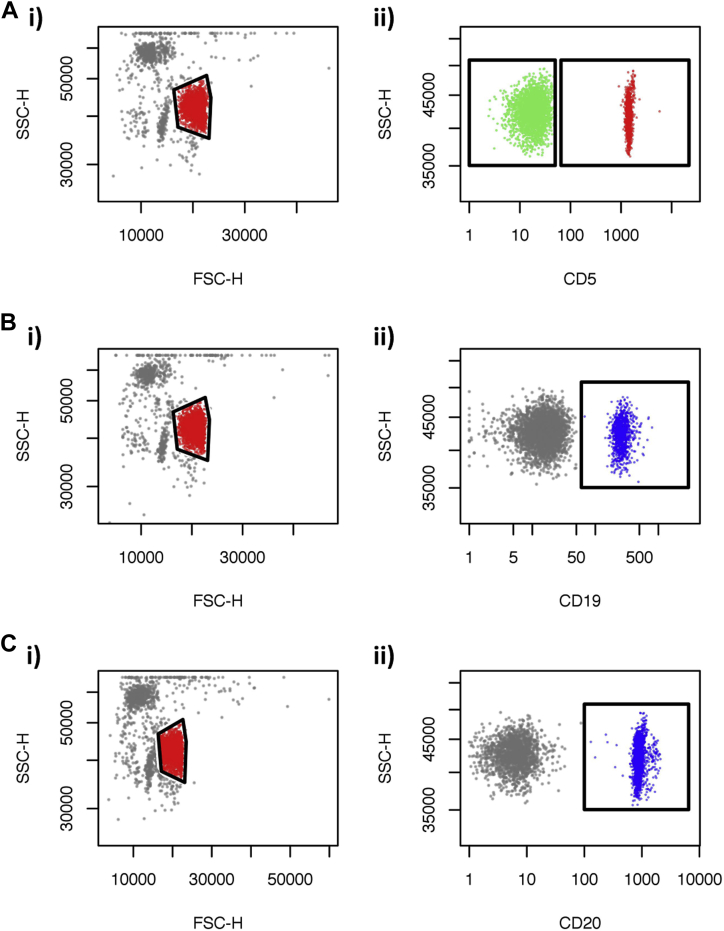
Optimizing gates for single-cell FACS sorting using beads. Polystyrene microparticle beads were mixed with the fluorochrome-conjugated human antibodies to optimize fluorescence gating settings for flow cytometric single-cell sorting of CD5high and CD5low B cells. After gating of monomeric microparticle beads, indicated by the red gates in part (i) in each panel, the (A) CD5high and CD5low gates (red and green, respectively) were set around the positive and negative control CD5 microparticle beads, (B) CD19 positive gates (blue), and (C) CD20 positive gates (blue).